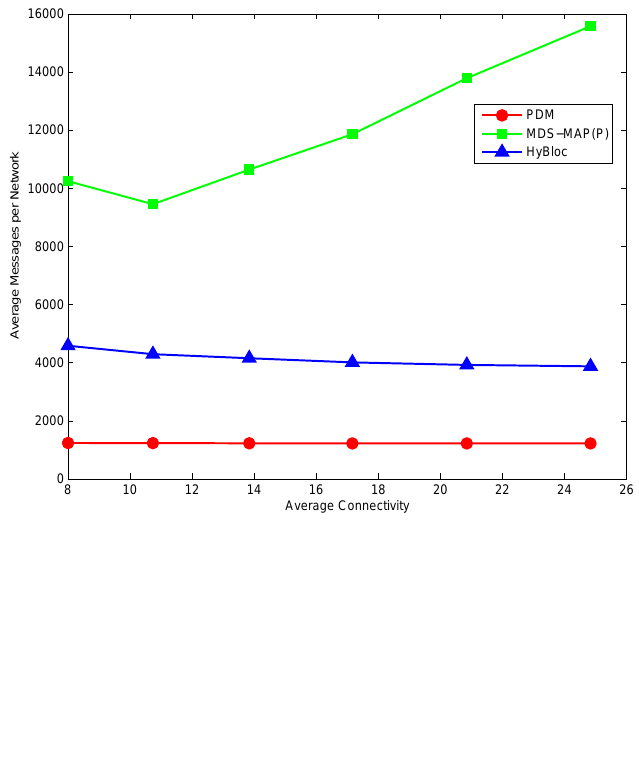
Figure 20 . Average number of messages transmitted per uniform network.